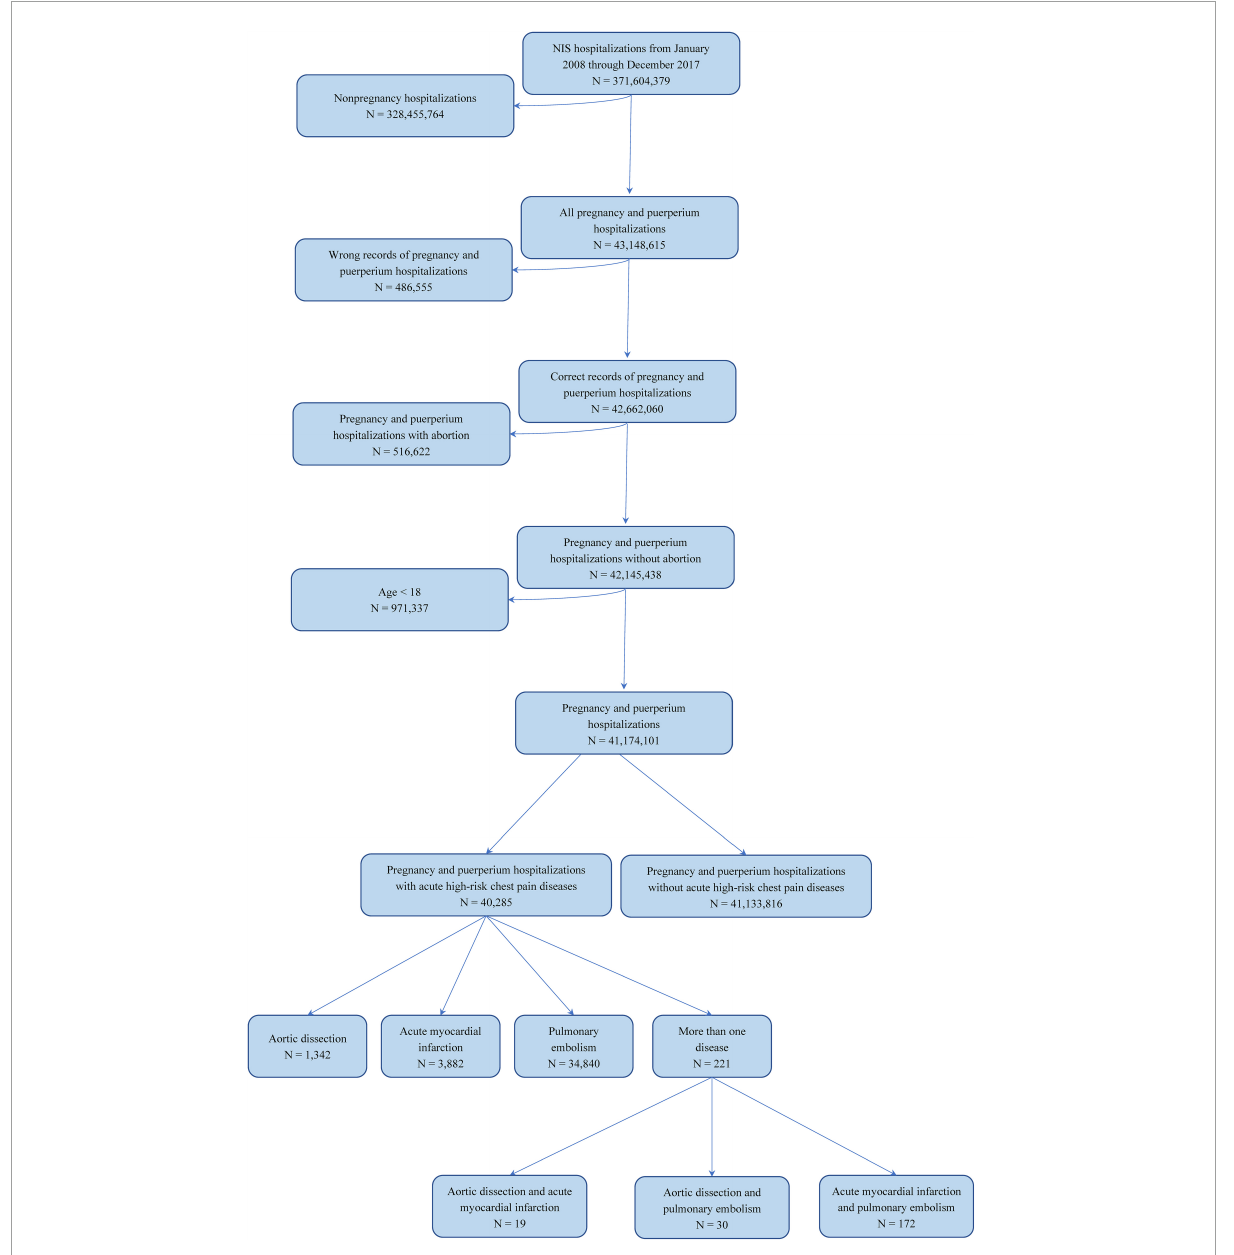
FIGURE1 Selection flow diagram of target population. Flow diagram to identify how the study cohort was